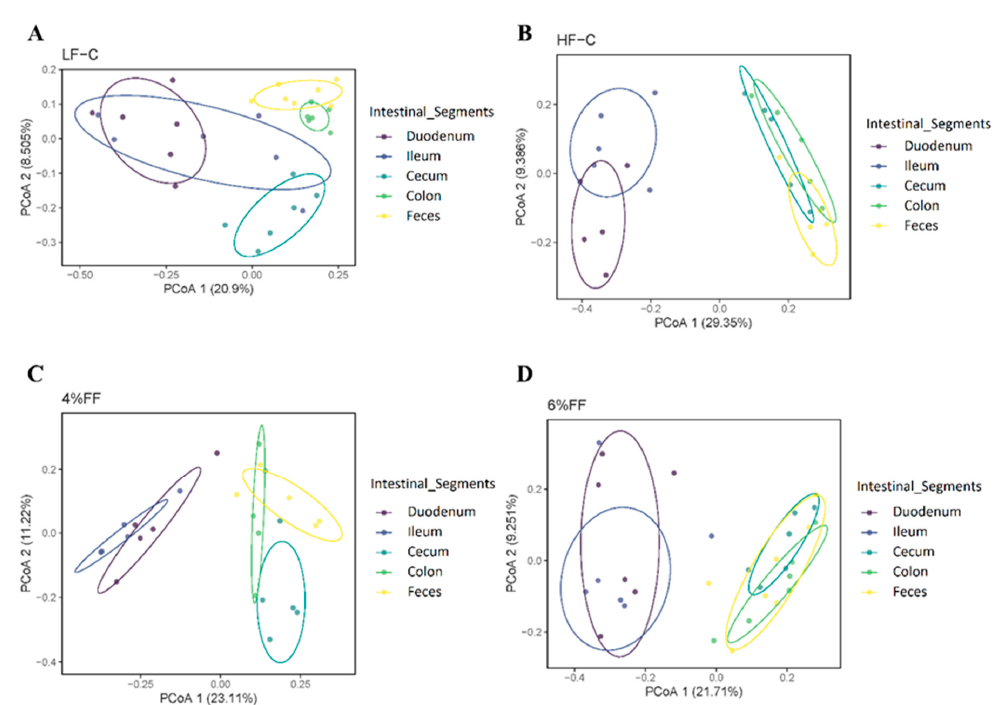
Figure 4. Principal coordinate analysis of different intestinal segments in each group ( n = 5–7): ( A ) LF-C, ( B ) HF-C, ( C ) 4% FF, and ( D ) 6% FF.